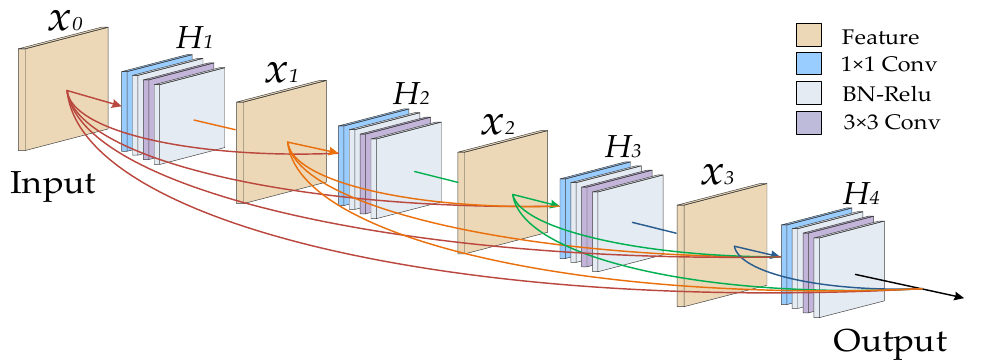
Figure 1. The DUP network structure diagram.